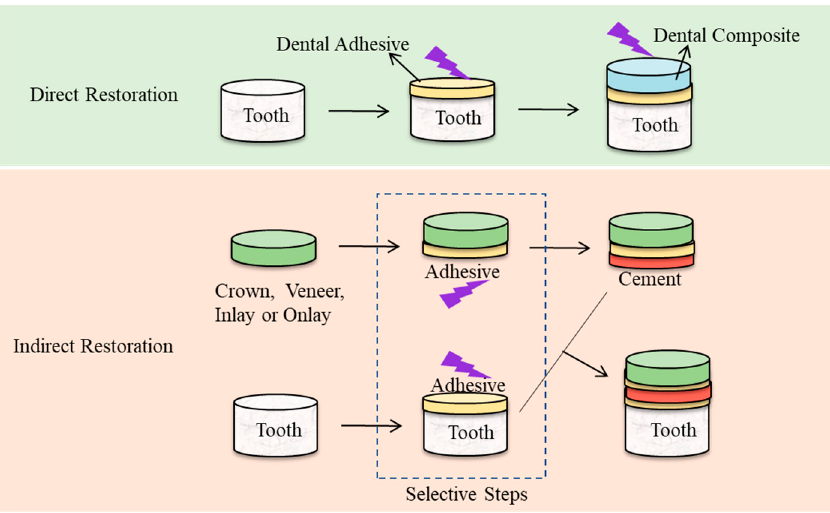
Figure 1. Resin-based materials applied in direct and indirect restorations